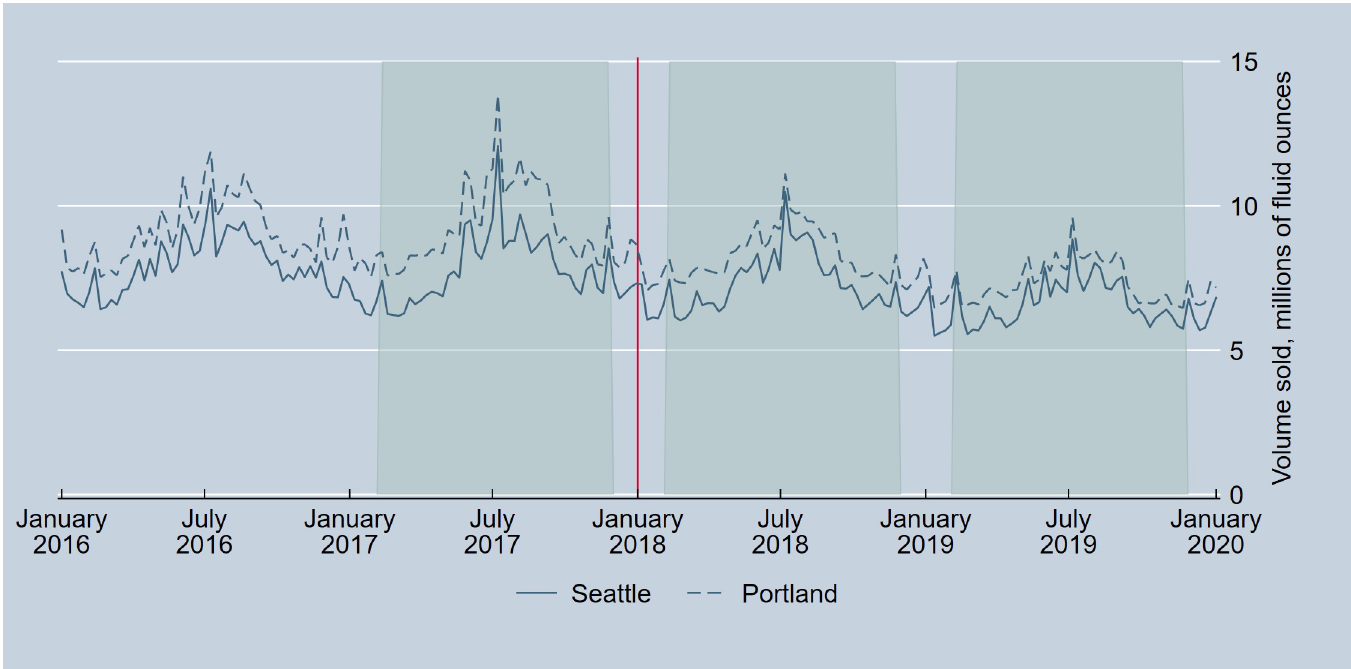
Fig 1. Volume sold of beer in Seattle, Washington, and Portland, Oregon, pre- and post-implementation of the Seattle Sweetened Beverage Tax. The vertical line indicates the date of tax implementation. Shaded regions correspond to the analytical time periods.